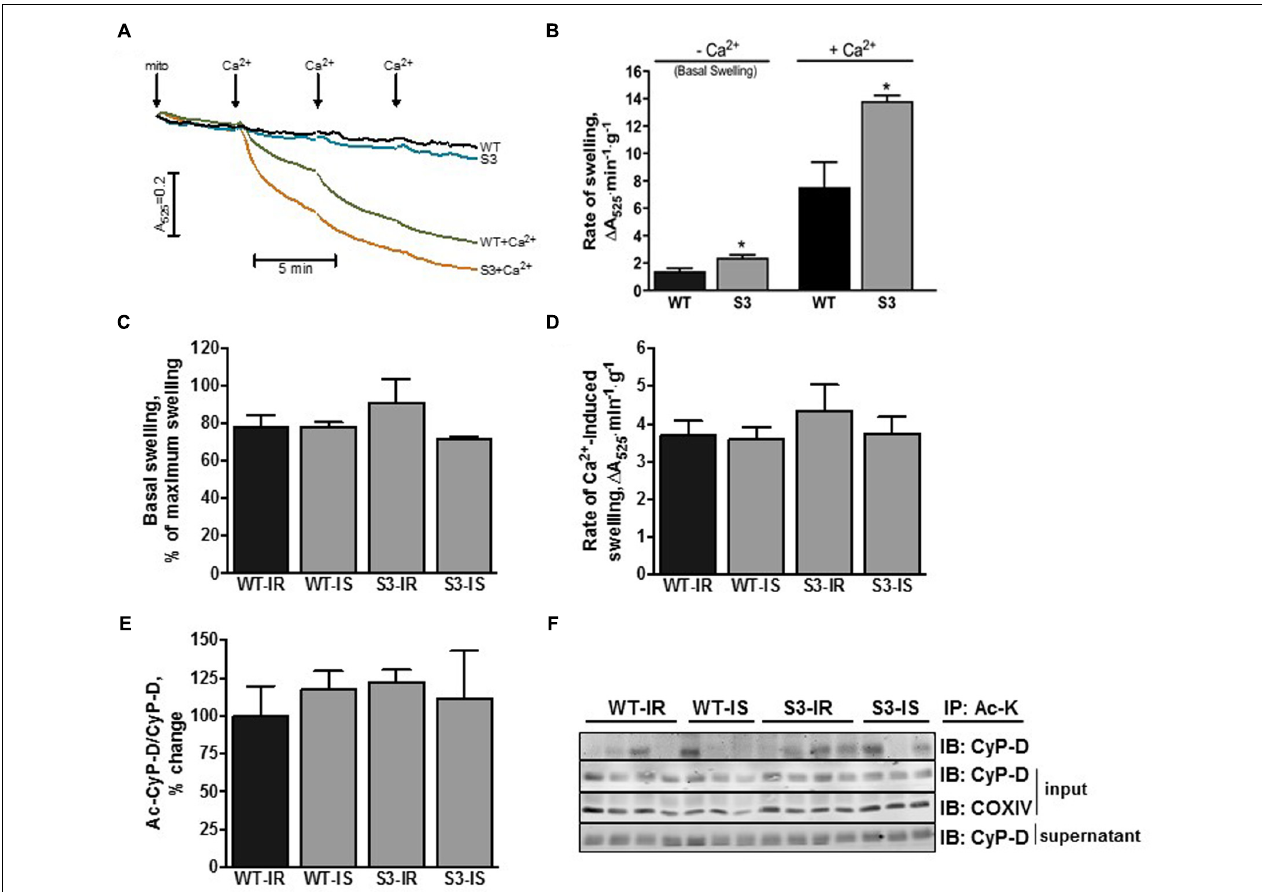
FIGURE 3 | Mitochondrial PTP opening and CyP-D acetylation in WT and SIRT3 − / − mice. (A) Representative graph of mitochondrial swelling on intact WT and SIRT3 − / − cardiac mitochondria. Basal (non Ca 2 + -induced) mitochondrial swelling of (B) intact or (C) perfused WT and SIRT3 − / − hearts. Rate of mitochondrial Ca 2 + -induced swelling as a marker of mPTP opening of (B) intact or (D) perfused WT and SIRT3 − / − hearts measured as the slope at 200 mM of CaCl 2 . (E) Quantitative data of acetyl-CyP-D in mitochondria presented in (F) . (F) Representative immunoblots of acetyl-CyP-D in mitochondria isolated from hearts after IR. Acetylated proteins in liver and cardiac mitochondria were immunoprecipitated using antibodies against acetylated lysine, and then resolved by SDS-PAGE and immunoblotted using CyP-D antibodies. Groups are the same shown in Figure 1 . S3, SIRT3 − / − mPTP formation from mitochondria of intact hearts in the absence of Ca 2 + ; S3+Ca 2 + , SIRT3 − / − mPTP formation from mitochondria of intact hearts in the presence of Ca 2 + ; WT, mPTP formation from mitochondria of WT